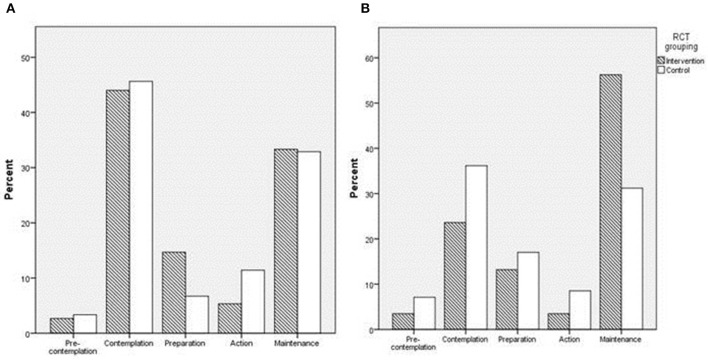
Bar charts representing the distribution of participant behavioral stage-of-change scores for physical activity in each group at (A); 15.6 weeks', and (B); 28 weeks' gestation.